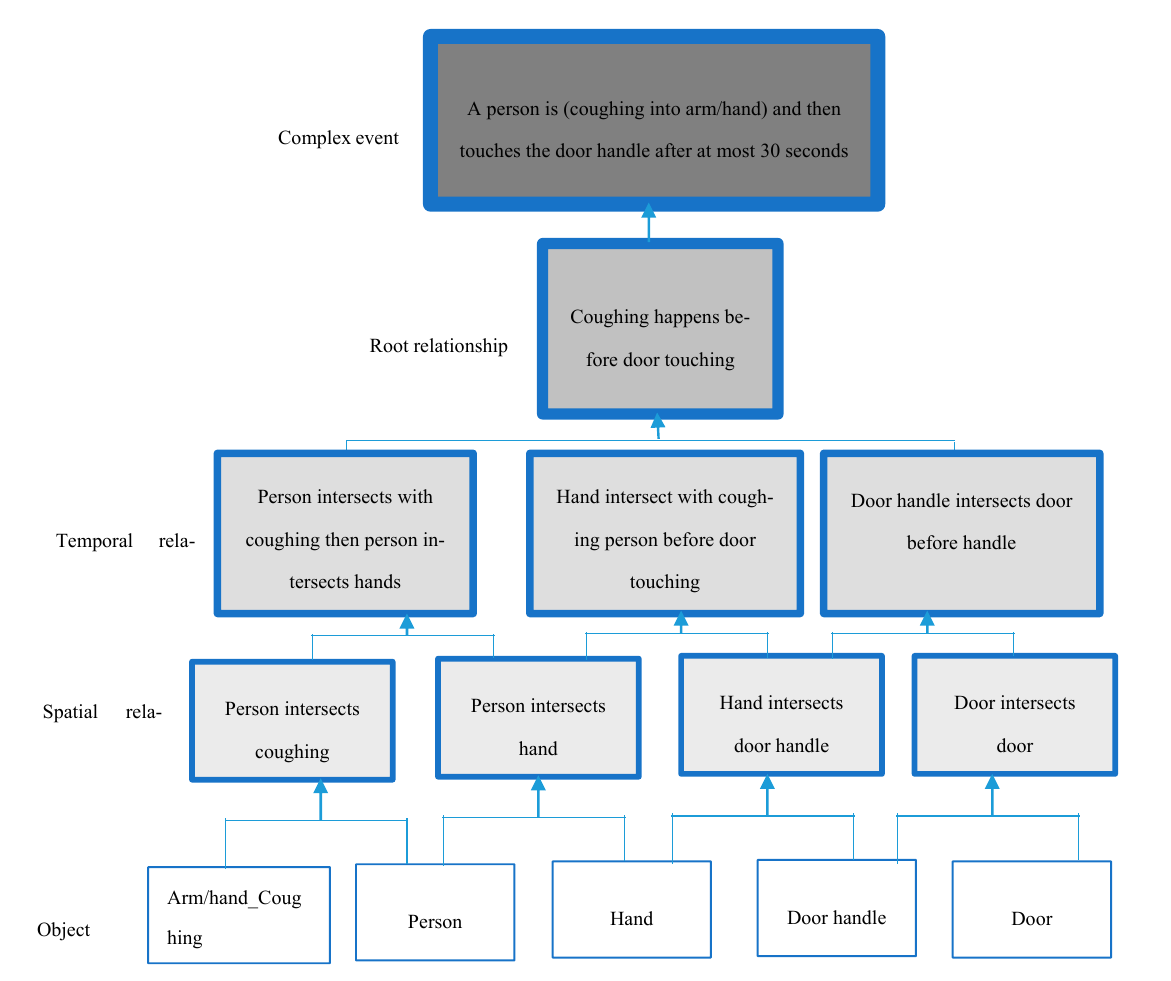
Figure 6. Spatial, temporal, and object relationships graph for risky behaviours.